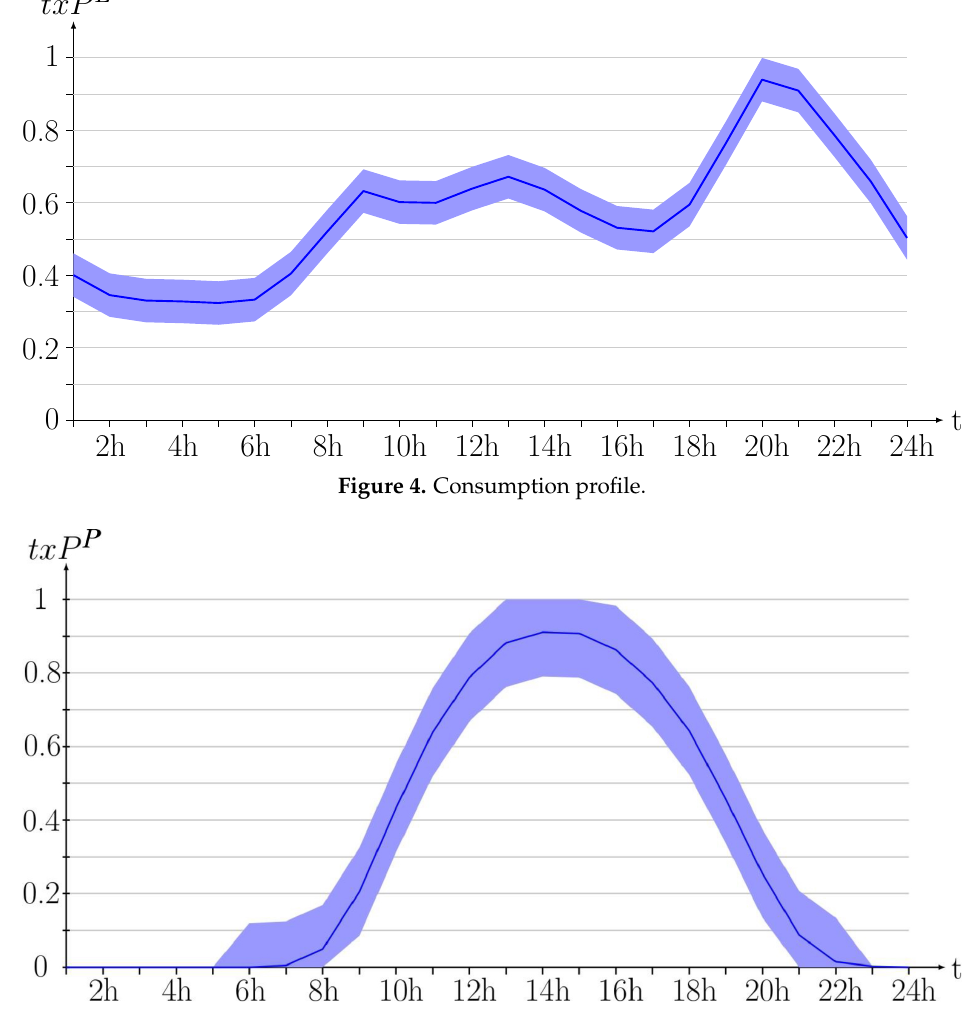
Figure 5. Solar production